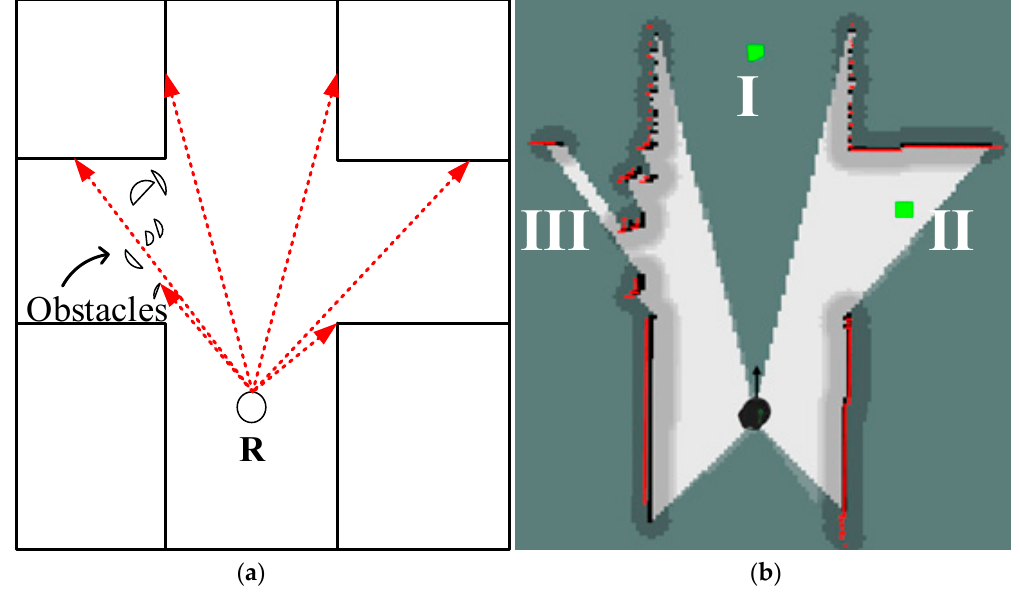
Figure 7. Generating candidate target point experiment: ( a ) sketch map; ( b ) actual effect.